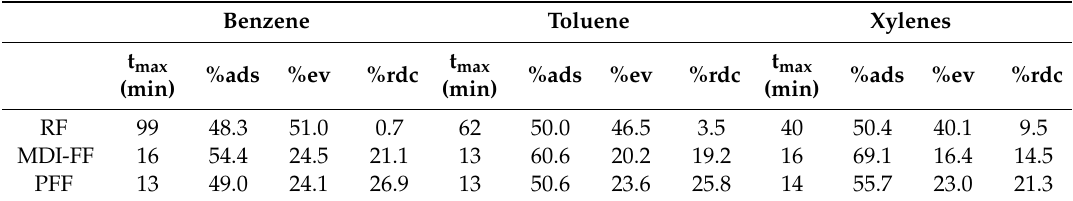
Table 5. Maximum BTX adsorption percentages (%ads) and related time of occurrence (t max ) in the water polluted open system. Evaporation (%ev) and residual dissolved concentration (%rdc) percentages taking place at the same aforementioned